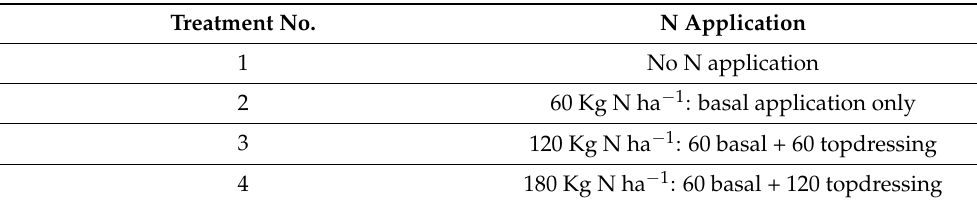
Table 1. N treatments for wheat grown in the greenhouse. Treatment No.